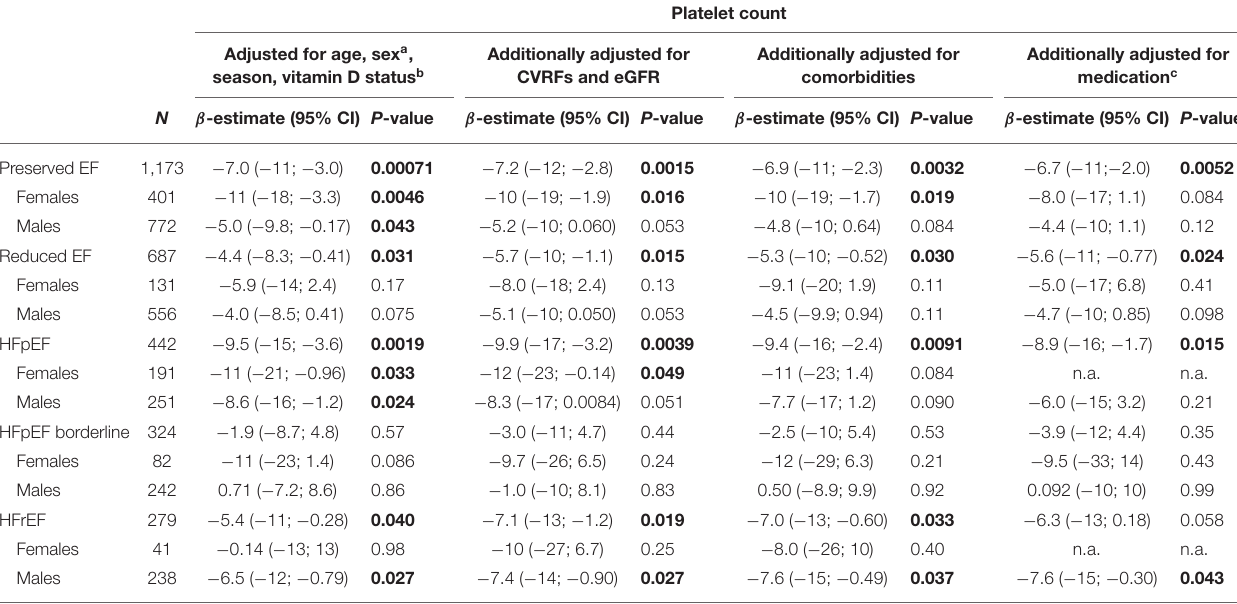
TABLE 3 | Relation between platelet count and PTH according to cardiac function in a sex-specific analysis. Adjusted for age, sex a , season, vitamin D status b